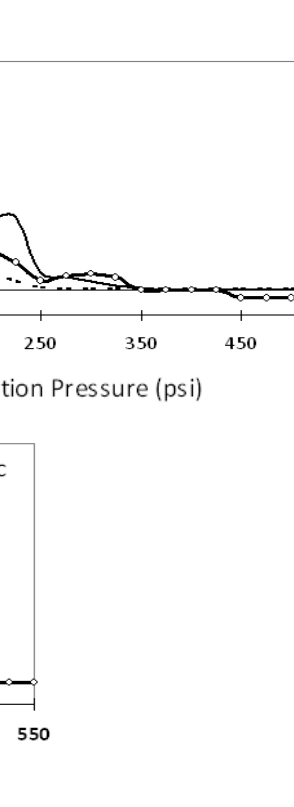
particle size for Al ( a ) N 32